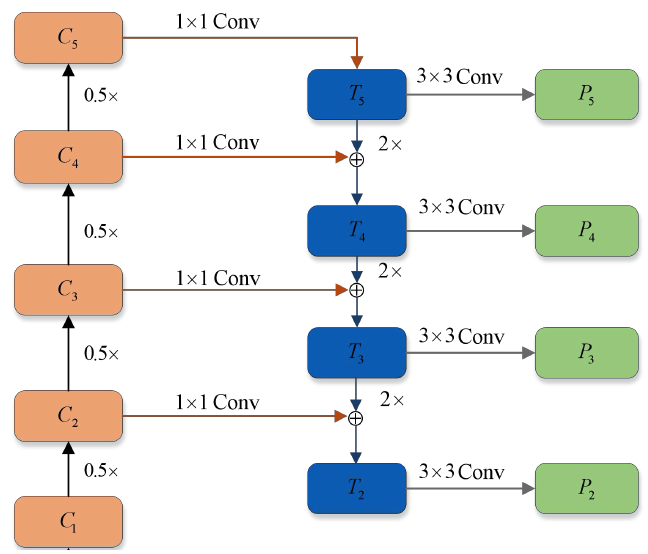
Figure 4. Architecture of the initial